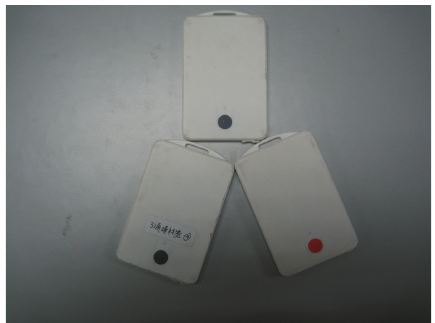
Figure 3: WiFi-compatible card.